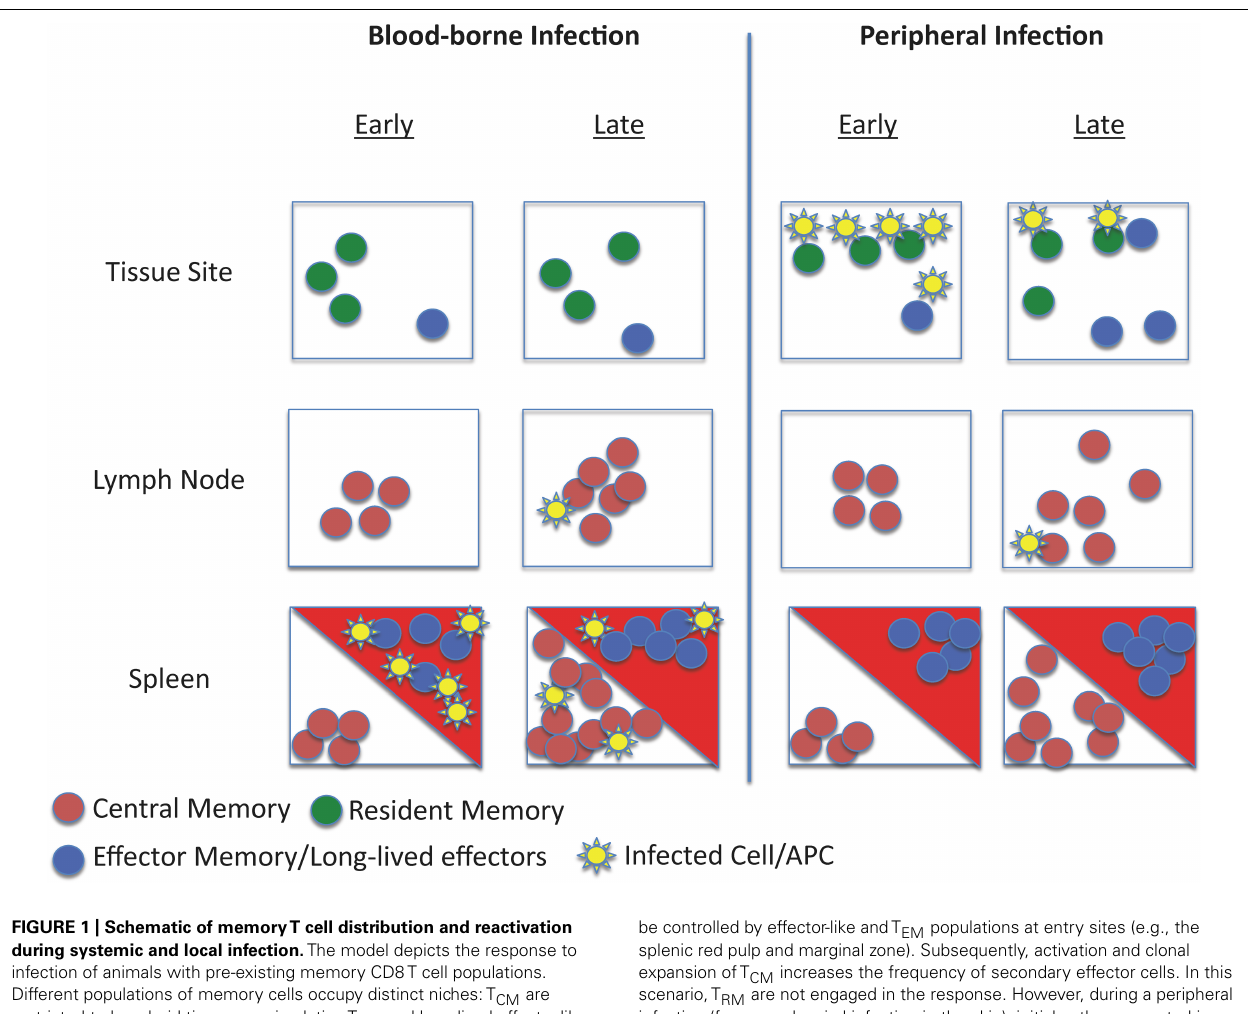
be controlled by effector-like andT EM populations at entry sites (e.g., the splenic red pulp and marginal zone). Subsequently, activation and clonal expansion ofT CM increases the frequency of secondary effector cells. In this scenario,T RM are not engaged in the response. However, during a peripheral infection (for example, viral infection in the skin), initial pathogen control is mediated by theT RM pool.This inflammatory response may recruit circulating T EM (and, potentiallyT CM ) to the site of infection. Subsequent responses initiated in draining lymphoid tissues would control systemic